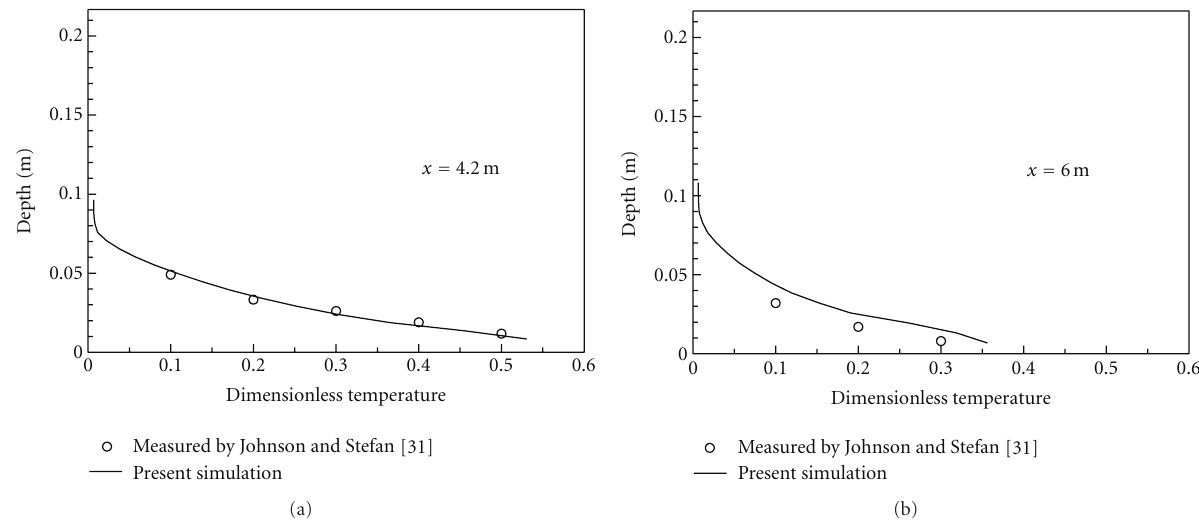
Figure 3: Comparison of simulated dimensionless temperature and experimental results of Johnson and Stefan [31] at two sections.